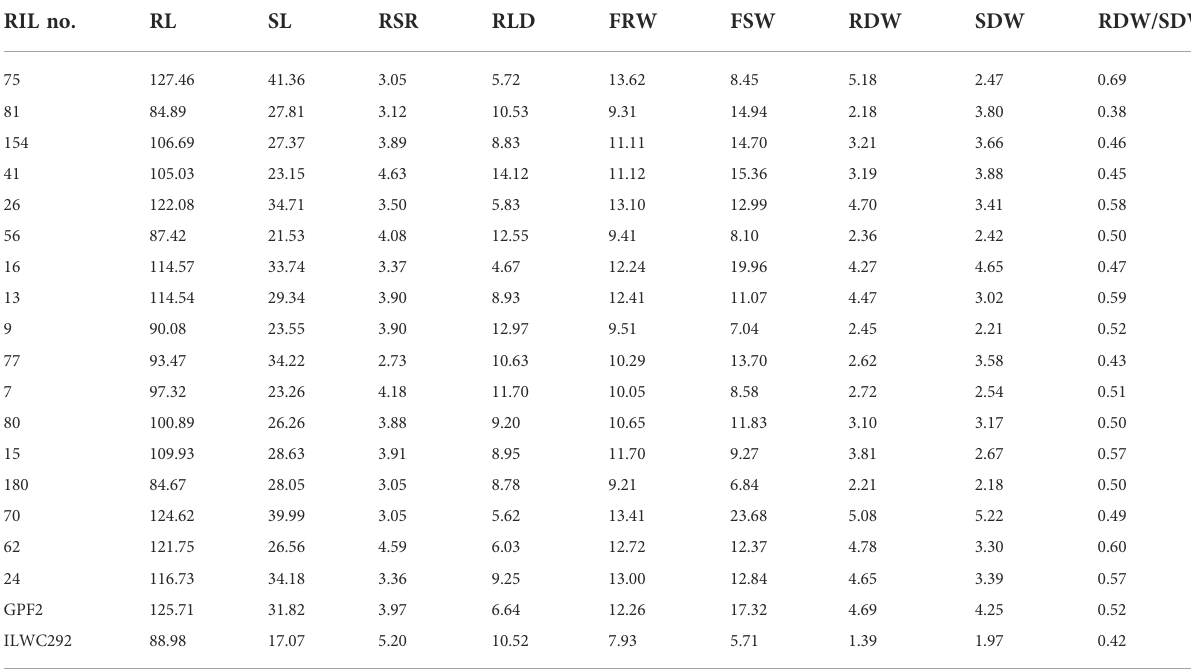
TABLE 4 List of promising recombinant inbred lines for various root-related traits under rainfed conditions at Ludhiana. RIL